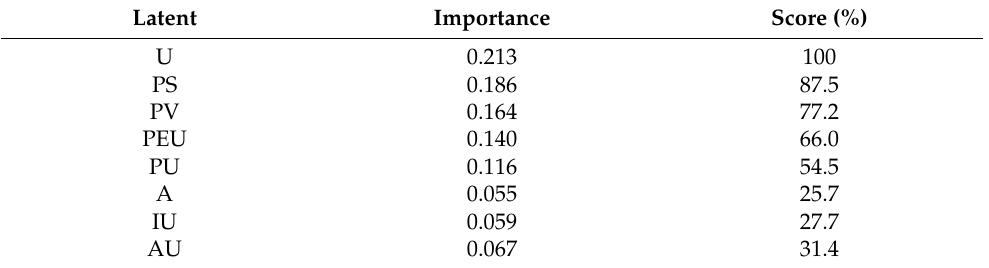
Table 5. Score of Importance.